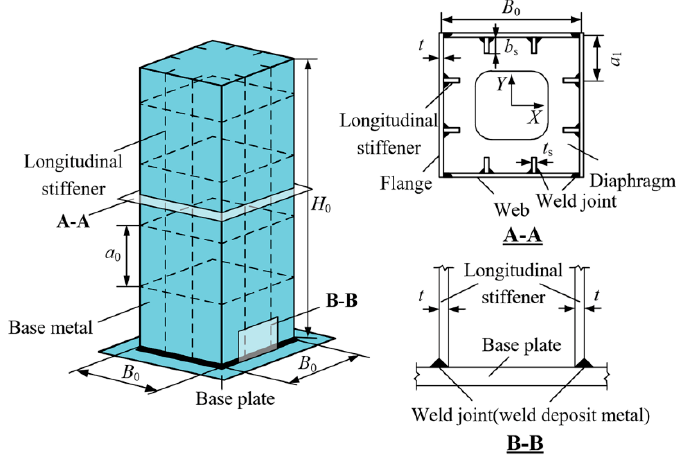
Figure 1. Schematic of a single-column steel bridge pier. Table 1. Geometric dimensions of steel bridge pier.